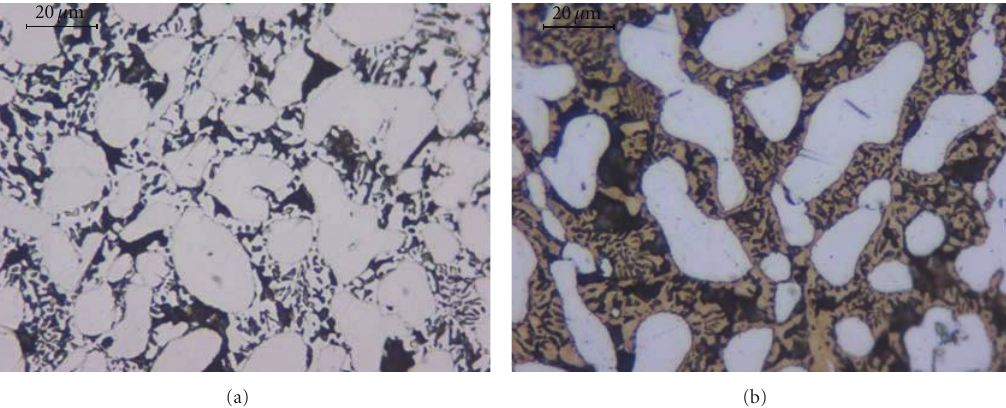
Figure 8: Optical micrographs after DLEPR test for sample aged at 725 ◦ C for 31622 min (a) after slightly polished (large austenite in white, attacked regions in black, sigma: small white regions) (b) electrolytically etched with NaOH (austenite in white, sigma in brown, attacked regions in black).